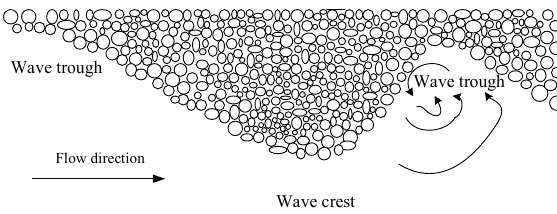
Figure 3. Schematic diagram of ice wave phenomenon.